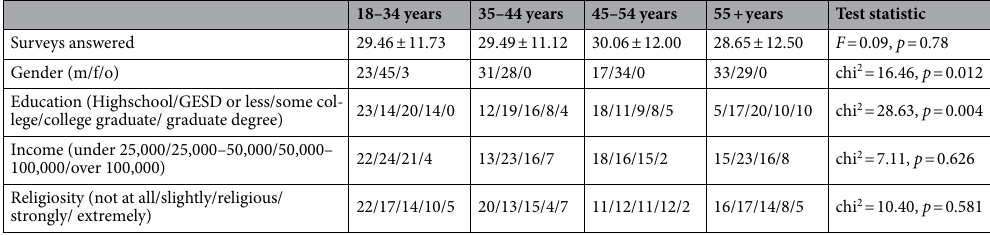
Table 3. Descriptive and interferential statistics of the final sample